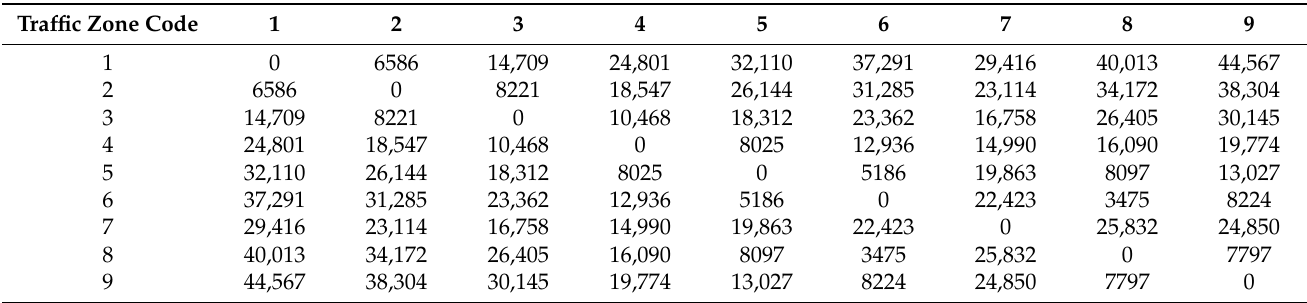
Table 2. Trip distances between different traffic zones (unit: